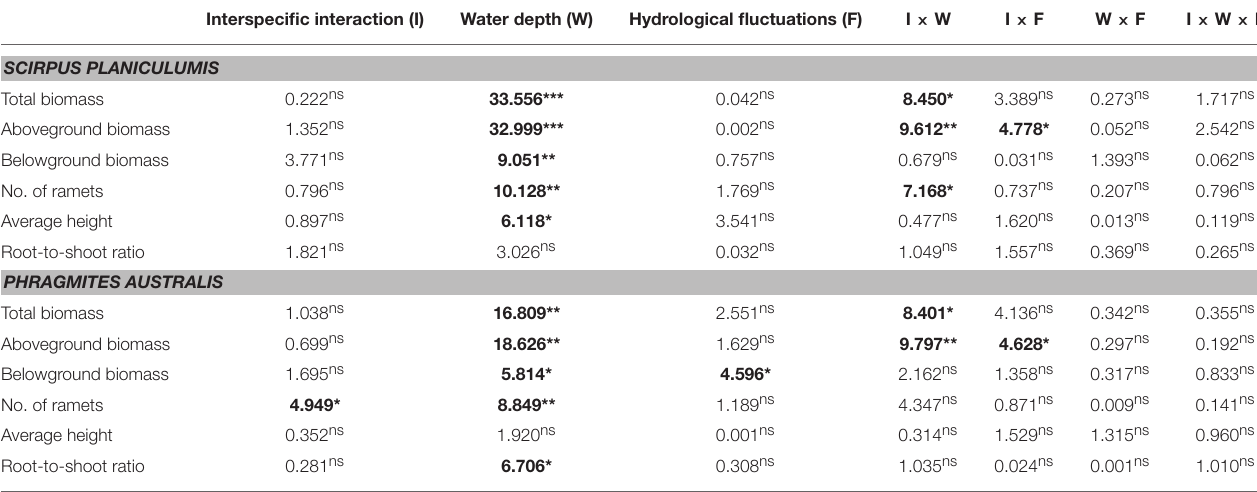
TABLE 2 | Three-way ANOVA results for the effects of interspecific interaction (with or without interspecific interactions), water depth (10 or 30cm water depth), and hydrological fluctuations (static or fluctuant water level) on the growth and morphological data for Scirpus planiculumis and Phragmites australis . Interspecific interaction